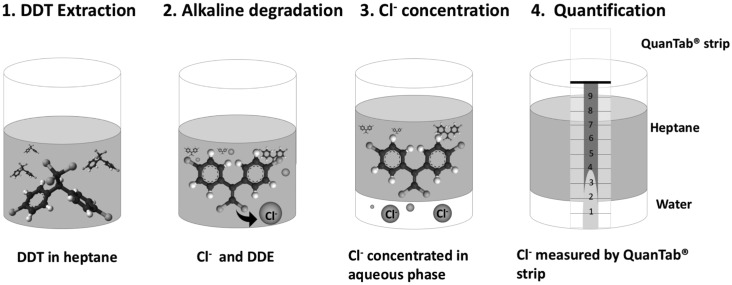
Schematic graph of the dipstick assay for determination of DDT.The assay operates through the concomitant release of chloride ion (Cl-) during alkaline-catalyzed DDT dehydrochlorination reaction that is measured by chloride Quantab Test Strips as follows: in Step 1 DDT is dissolved in heptane while contaminating ions remain undissolved and removed through transfer of DDT to a new tube. In Step 2 Cl- is released by KOH, neutralized in Step 3 with ~1/10th volume of aqueous acetic acid, which concentrates Cl- into the bottom aqueous phase. In Step 4, Quantab strip measurements of Cl- are taken from the aqueous phase allowing estimation of DDT concentration.